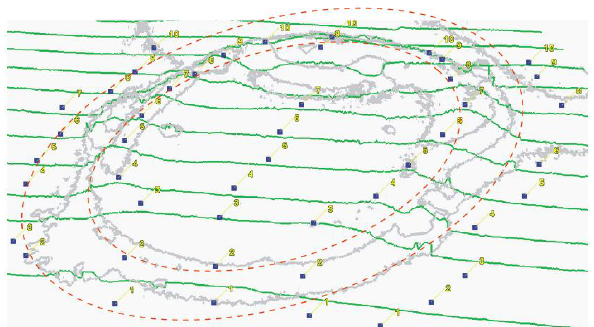
Figure 21. Sections and characteristic point of known settlement geometry – object